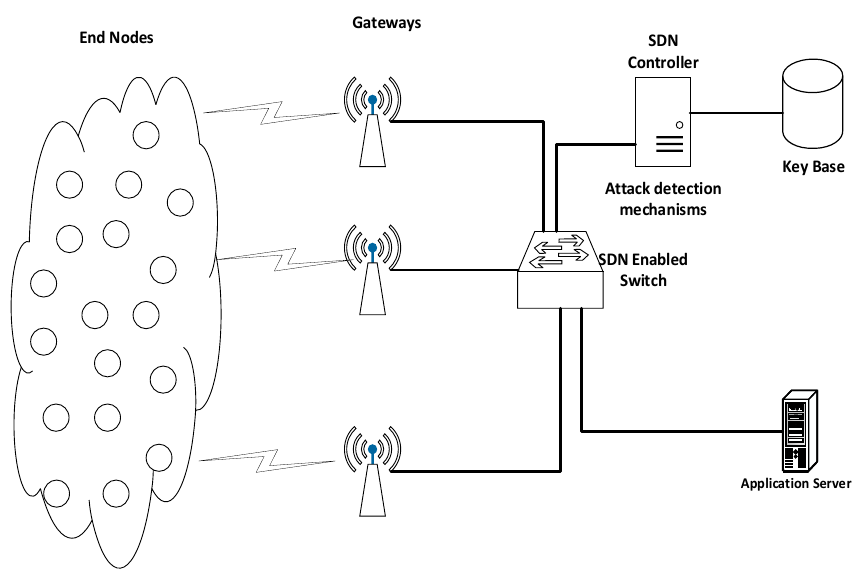
Figure 5. SDN-based architecture for LPWAN.